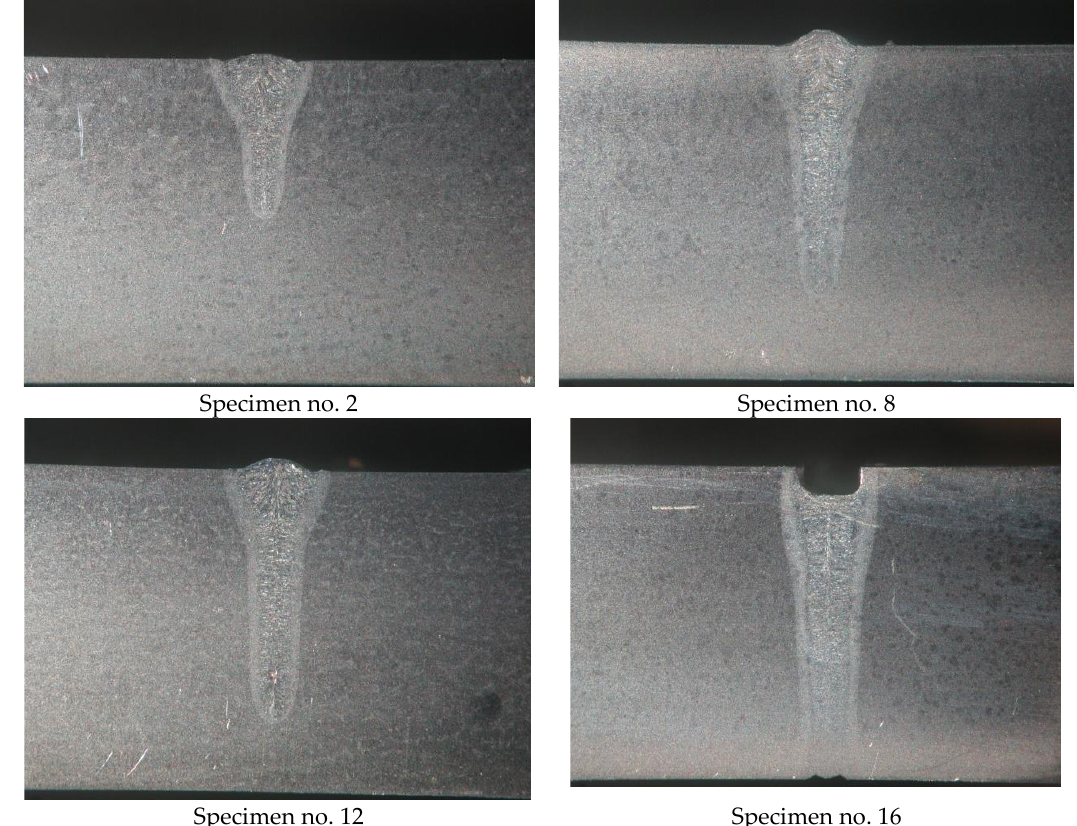
Figure 4. Macrostructures of the remelted specimens.